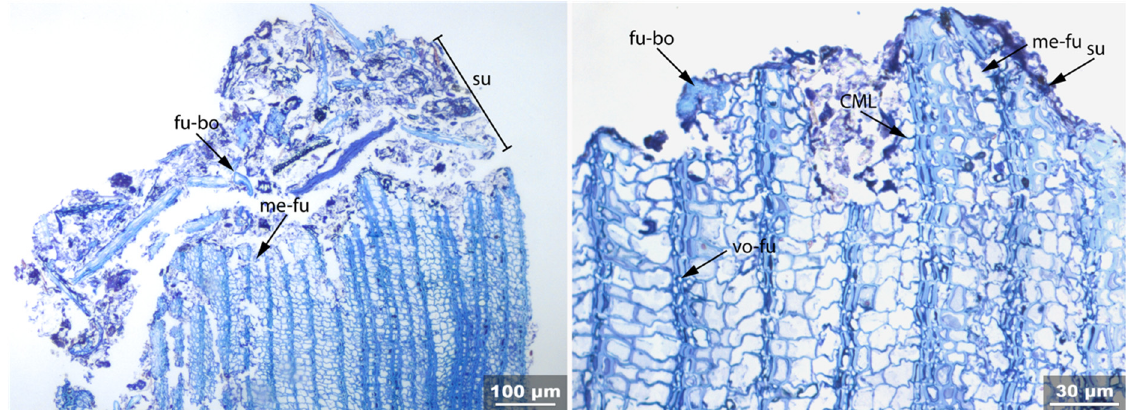
Figure 22. Sample 6 shows a superficial structure (su) consisting of cell fragments, fungal structures (fu-bo) and dark blue cloudy remains (left). Empty circular/oval voids in corners (vo-fu) of suberized cell walls of thick-walled cells caused swelling and then dissolution of secondary wall (right). At top of sample, complete disintegration of cell structure (me-fu) is visible. Fungal structures cause a loss of cell wall material (secondary cell wall, cell lumen filling material) and in an advanced state complete disintegration of all cell wall layers (me-fu).